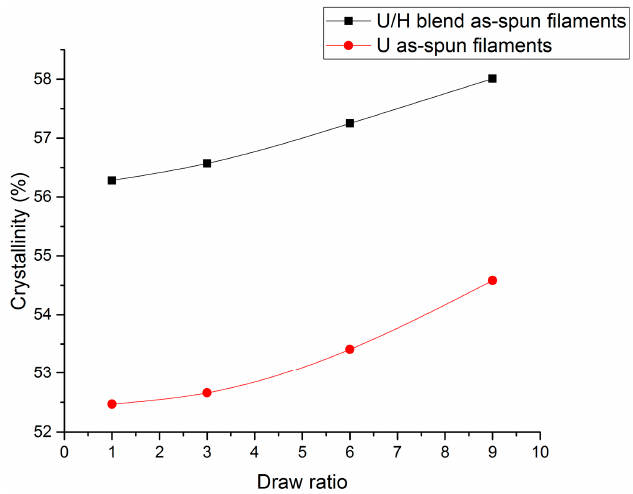
Figure 5. The crystallinity values of as-spun filament samples with different initial draw ratios.